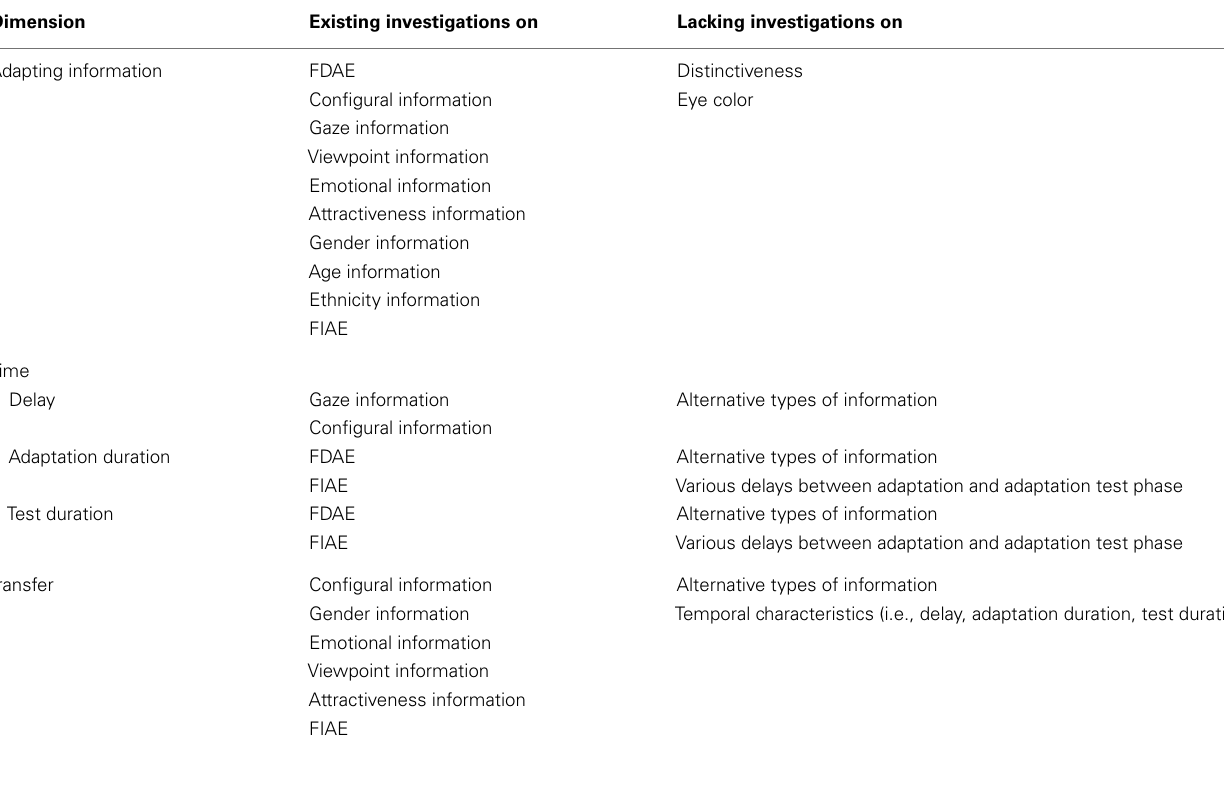
Table 4 | Overview of existing and lacking research in the field of face adaptation effects: what types of face information does this research include?What types are